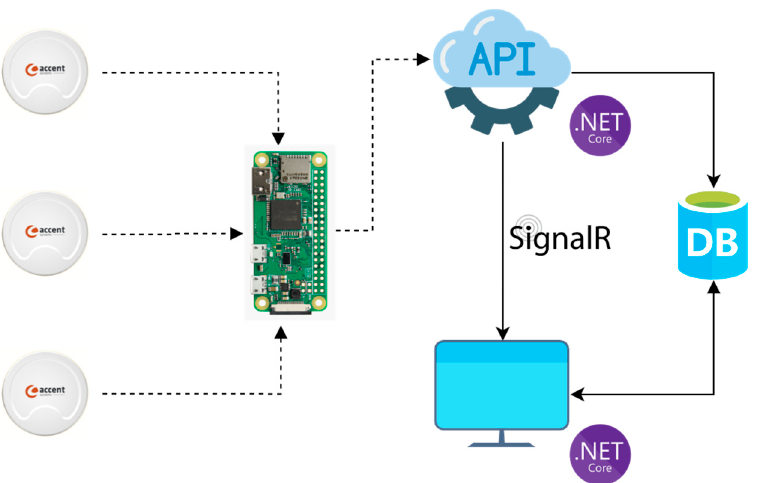
Figure 2. System